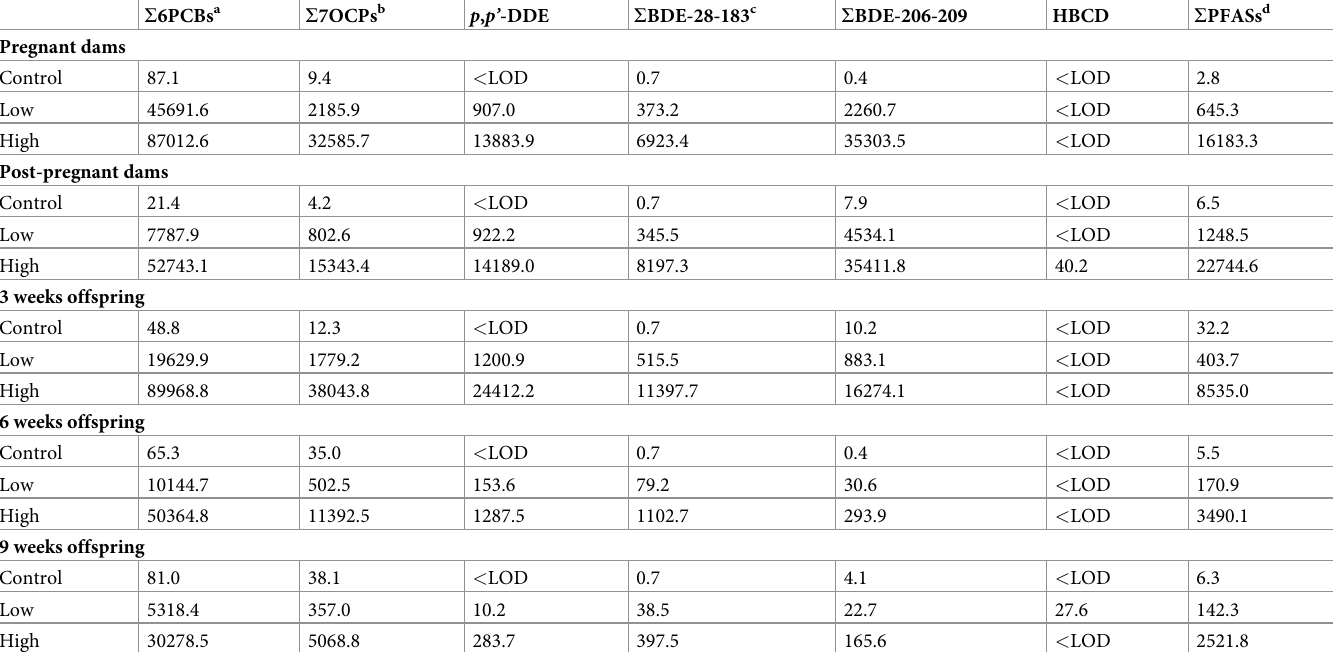
Table 2. POP concentrations in pooled